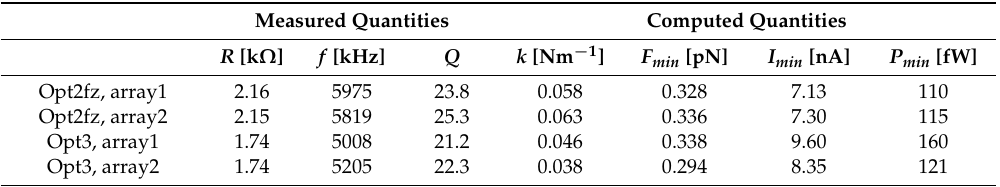
Table 6. Measurements on the Opt2fz and Opt3